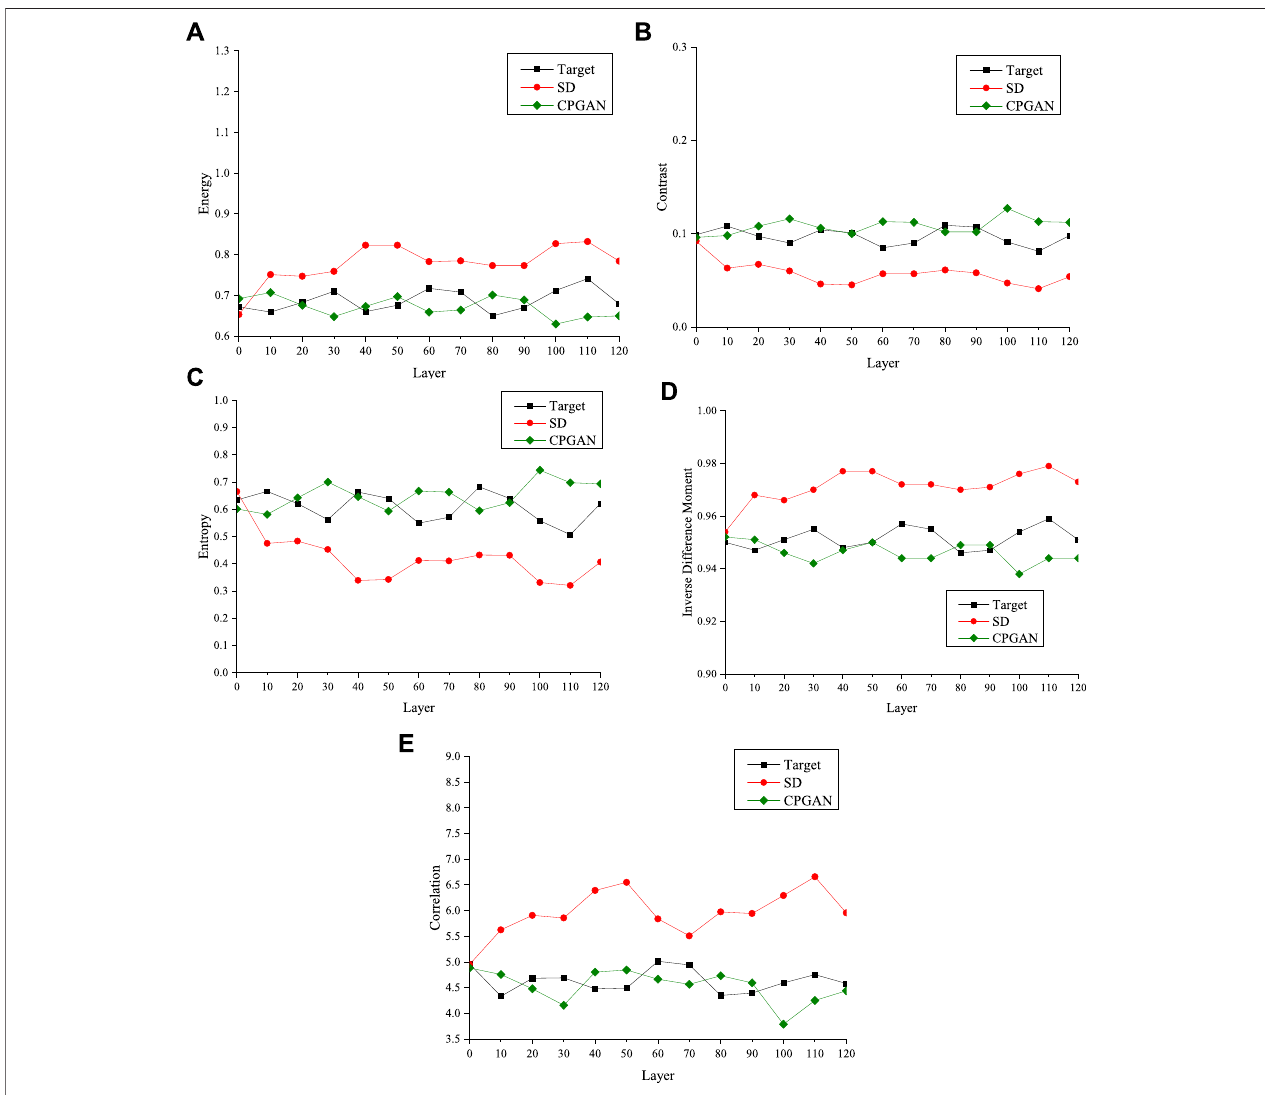
FIGURE 8 | Comparison of characteristic functions of structures reconstructed by different algorithms: (A) energy; (B) contrast; (C) entropy; (D) inversedifference moment; and (E) correlation.